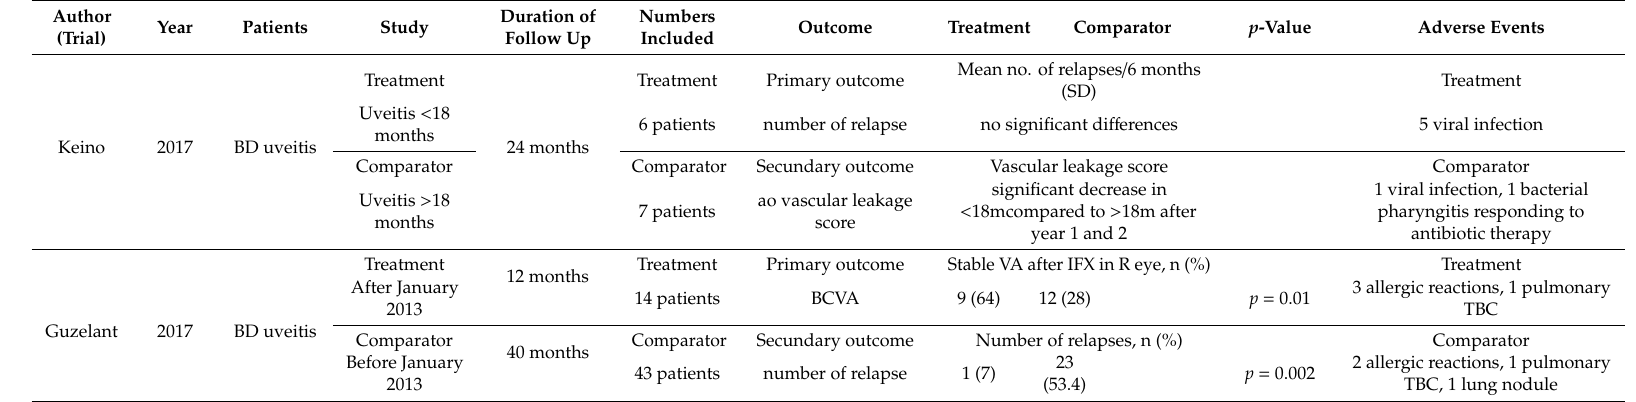
Table 3. Retrospective trials comparing infliximab in starting